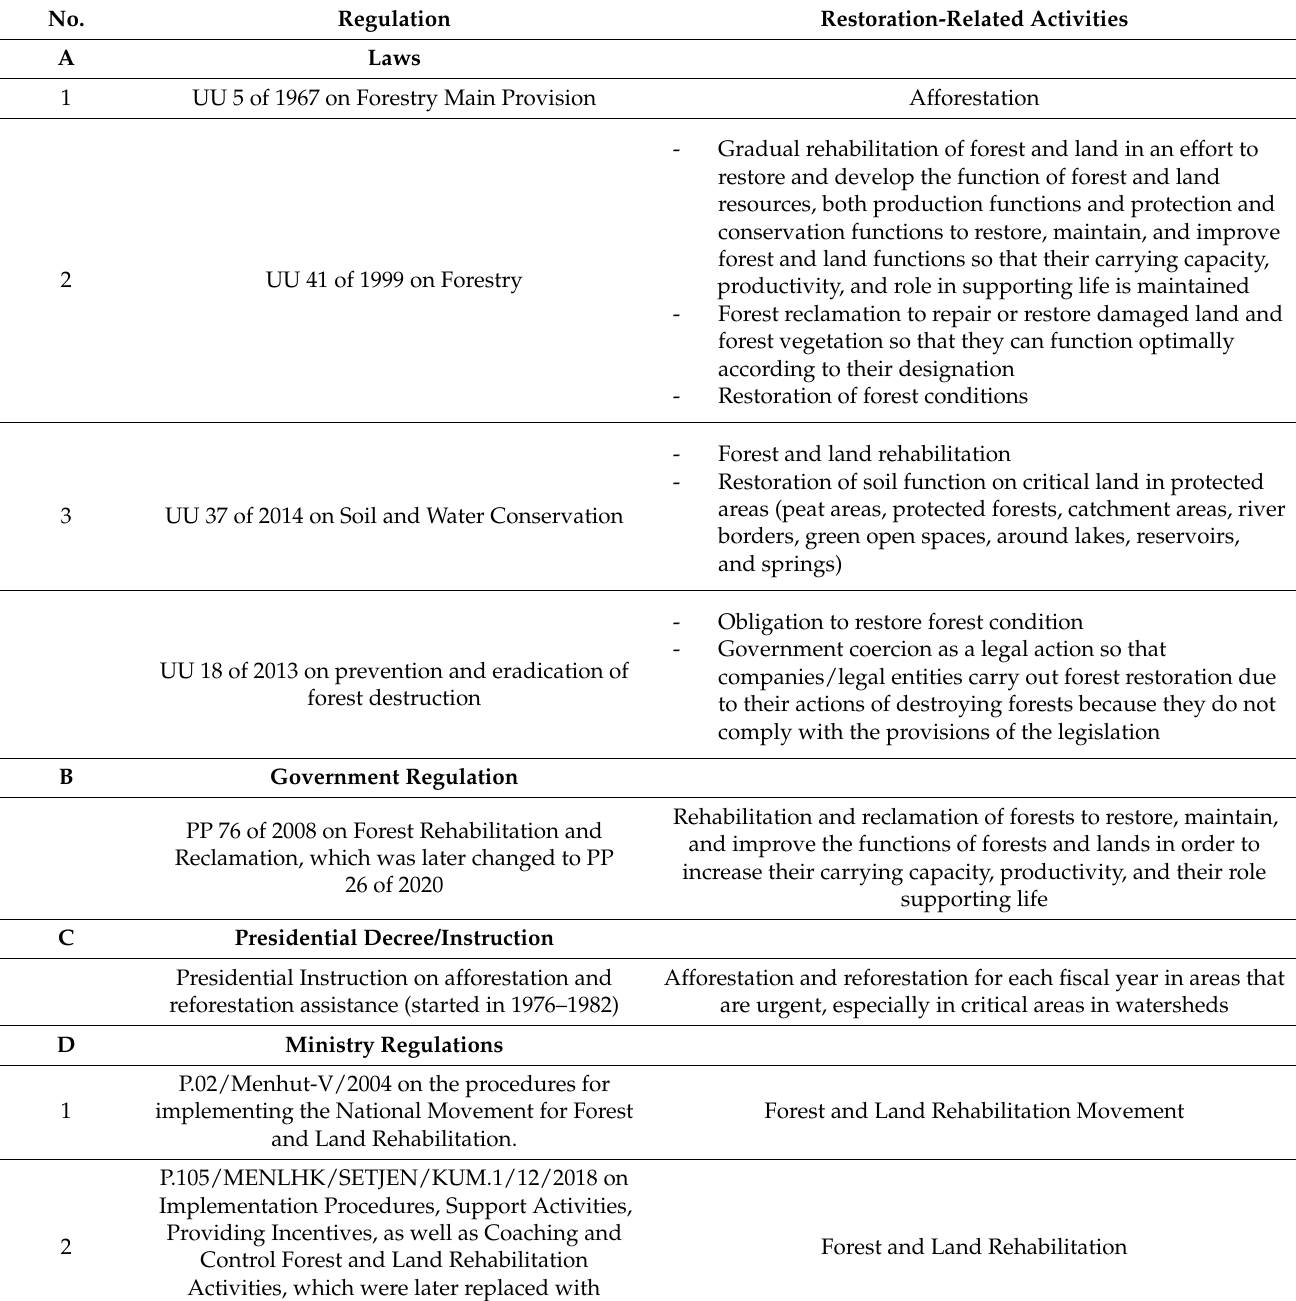
Table 1. Laws and regulations related to forestry in Indonesia governing forest